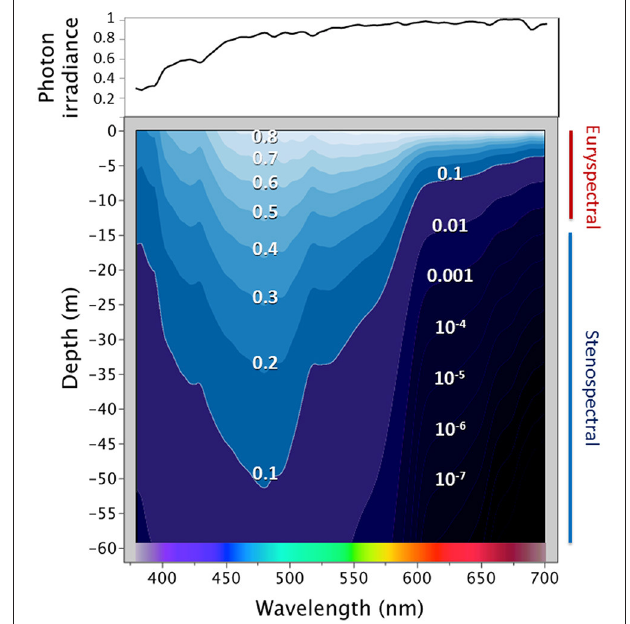
FIGURE 1 | The spectral light environment in tropical marine waters. The top graph shows the ambient spectrum above the water surface (expressed as a proportion relative to the highest irradiance value, Red Sea, March 2013). The lower graph shows how that proportion changes with increasing depth. Each line represents the “iso-brightness” for a given wavelength. Red wavelengths dominate near the surface, but 90% of their irradiance is absorbed within − 10 m. For blue light, the same degree of absorbance is only reached at − 50 m. Irradiance was measured using a calibrated PhotoResearch PR 670 photospectrometer fitted with a CR-670 cosine receptor between 0 and − 25m depth and is expressed in photons.s − 1 .m − 2 .nm − 1 . These data were used to calculate spectral attenuation coefficients to estimate values down to − 60m ( Meadows et al., 2014). Note that the measurements ignore Raman scattering, which is very weak but explains the presence of long wavelengths even in very deep water (Johnsen, 2012, p.